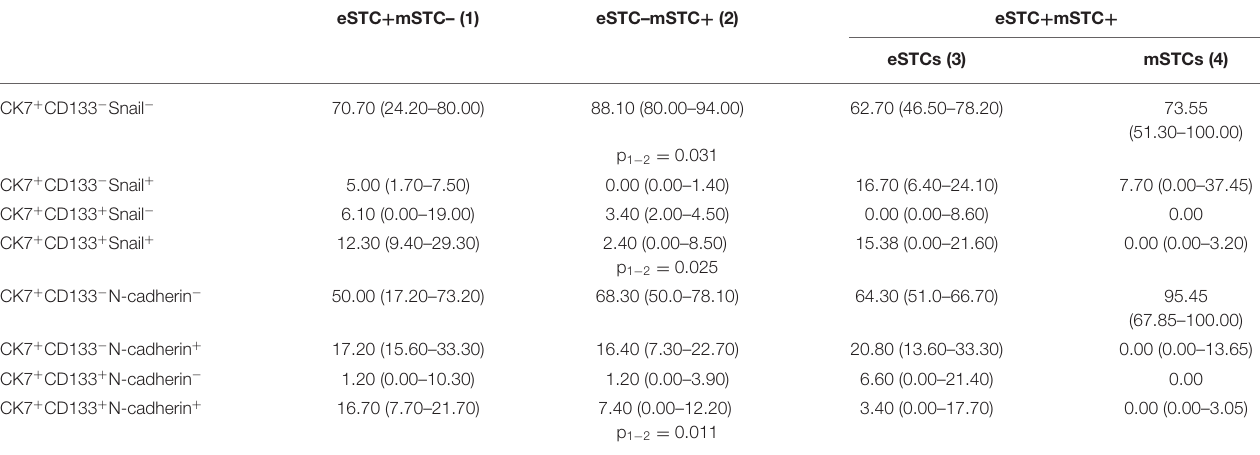
TABLE 5 | Percentage of cells with stem and EMT phenotypes among eSTCs and